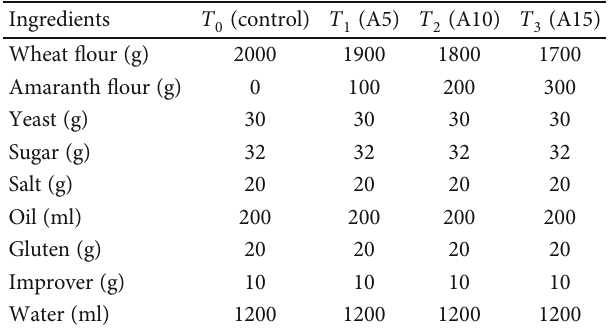
Table 1: Formulation of wheat amaranth composite bread.